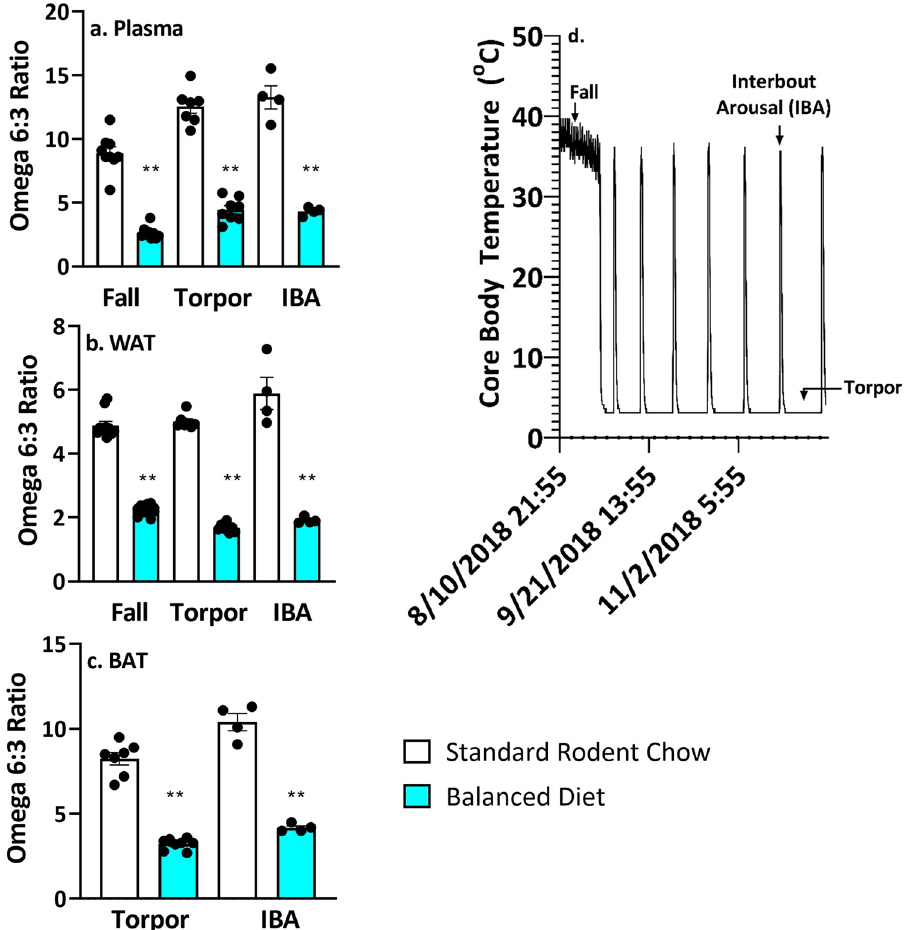
Figure 1. Omega 6:3 ratio is lower in plasma, WAT and BAT of Balanced Diet AGS. ( a ) Plasma, **p < 0.001, two tailed t-test, fall n = 9, torpor n = 7–8, IBA n = 4. ( b ) WAT, **p < 0.001, two-tailed t-test, fall n = 11–12, torpor n = 7–8, IBA n = 4. ( c ) BAT, **p < 0.001, two tailed t-test, torpor n = 7–8, IBA n = 4. ( d ) An example of time points when AGS were sampled over the hibernation season. Data shown are mean ± SEM. Black dots are individual data